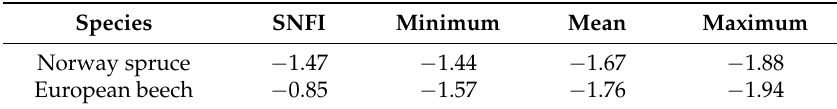
Table 5. Values of the self-thinning rule slopes found using NFI data and found in the